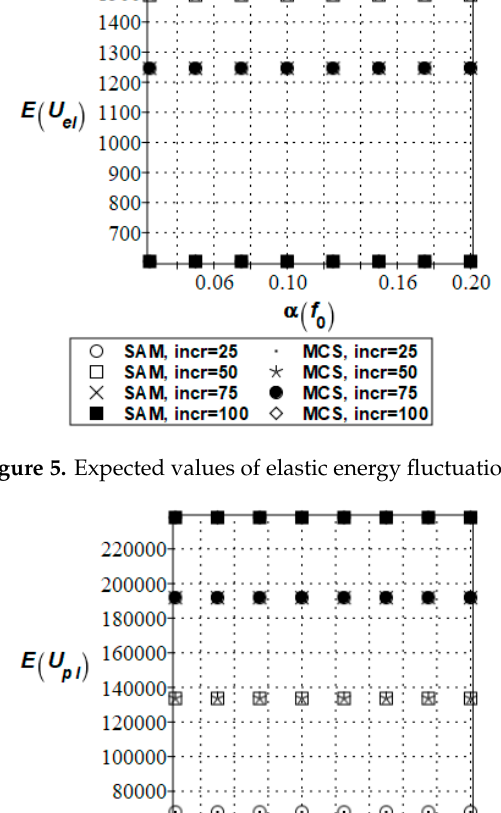
Figure 4. Plastic energy variations during deformation.